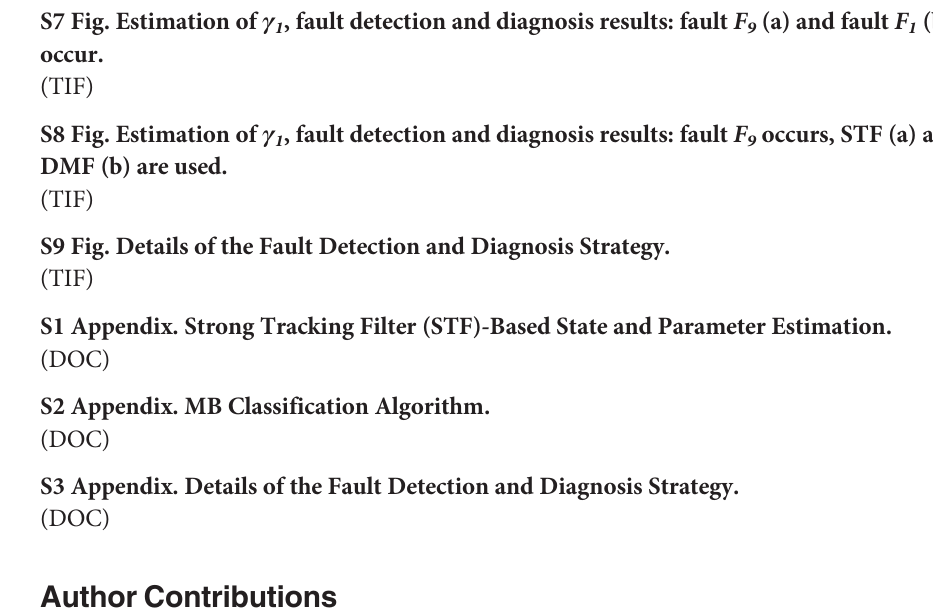
S7 Fig. Estimation of γ 1 , fault detection and diagnosis results: fault F 9 (a) and fault F 1 (b) occur. S8 Fig. Estimation of γ 1 , fault detection and diagnosis results: fault F 9 occurs, STF (a) and DMF (b) are used. S9 Fig. Details of the Fault Detection and Diagnosis